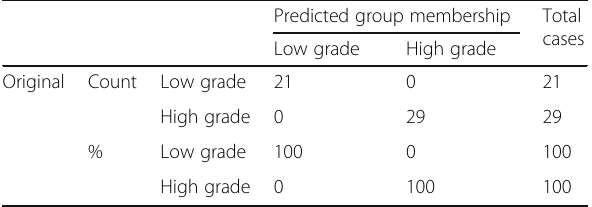
Table 4 Classification accuracy of the tumor mass with linear discriminant analysis including ADC value plus Cho/NAA mass plus rCBVt (leave-one-out method) (100% of cross-validated grouped casescorrectly classified; 100% of original grouped cases correctly classified) Predicted group membership Total cases Low